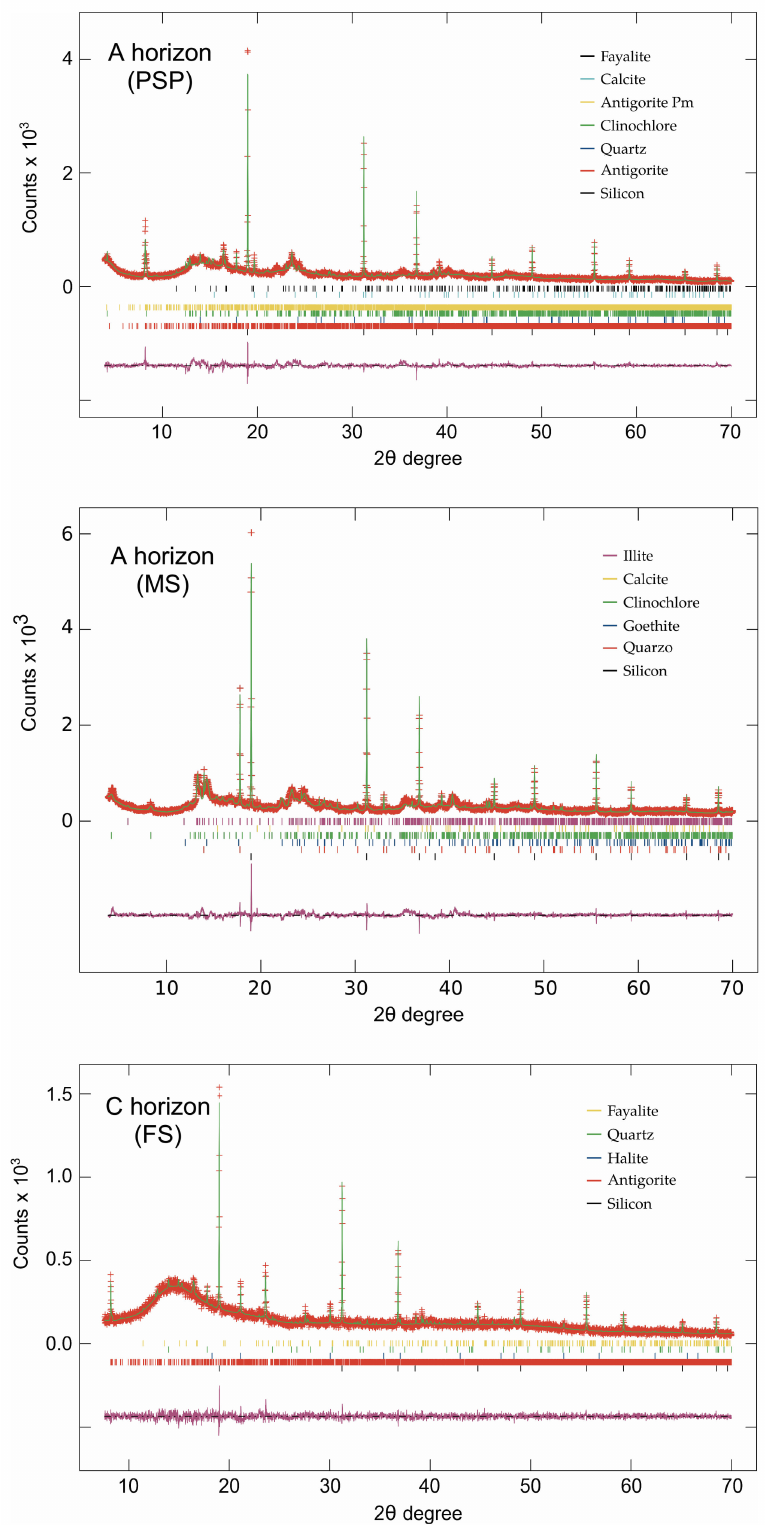
Figure 4. Refined XRPD patters of the silt fraction of representative samples. The red crosses are the observed data and the green profiles are the calculated pattern. The di ff erence curve is shown in purple. Bars at the bottom of the graphs are the mineral phases reference di ff raction peaks; see the legends to attribute colors to phases (from top to the bottom). Silicon is the internal standard added to the sample to determine the amorphous